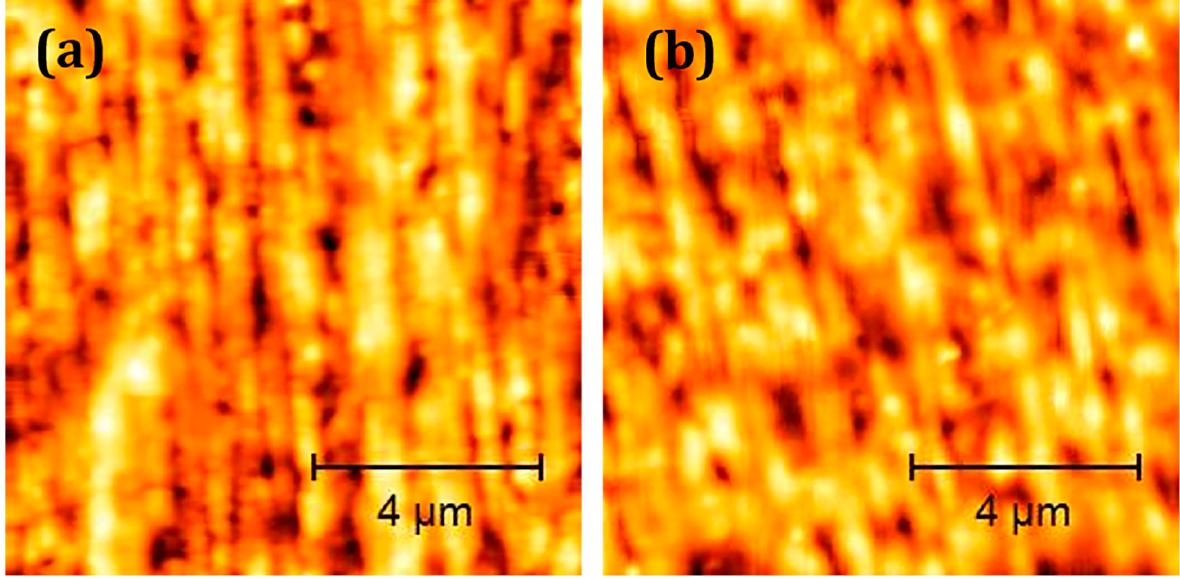
Figure 4. AFM images of ( a ) untreated PBS, ( b ) PBS coated with a SiO x C y H z (25 nm thickness) + SiO x (25 nm thickness)).